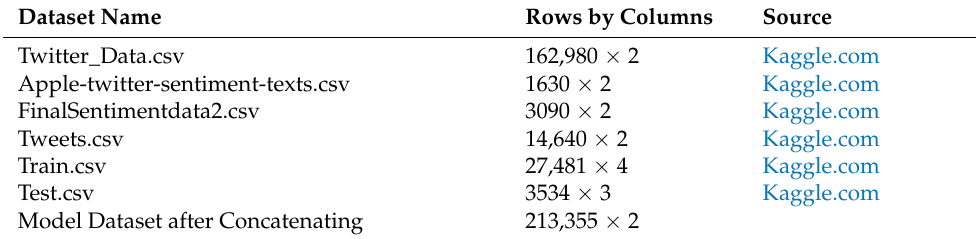
Table 1. Dataset composition.